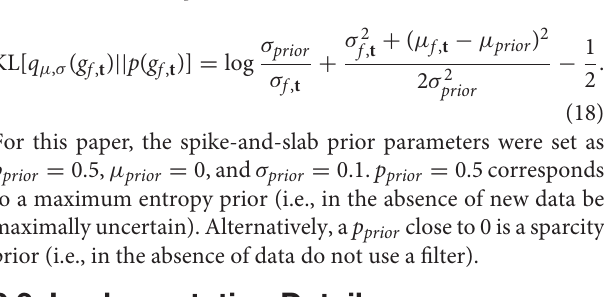
TABLE 3 | The average and standard deviation of the class Dices across test volumes for the maximum a posteriori (MAP), MC Bernoulli dropout (BD), and spike-and-slab dropout (SSD) network on the in-site and out-of-site test